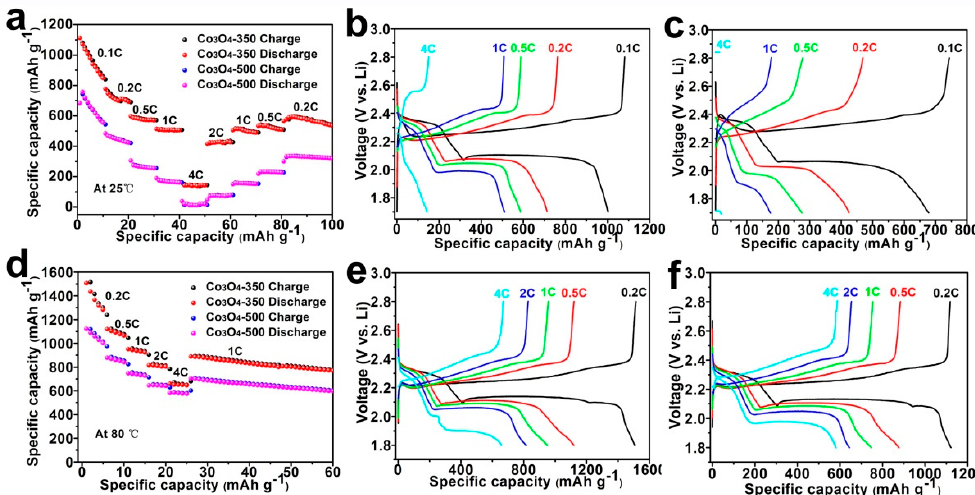
Figure 5. The rate capability of Li–S cell using varied separators at room temperature ( a ) and 80 ◦ C ( d ). The galvanostatic charge / discharge profiles of Li–S cell using Co 3 O 4 -350 / PI / LLZO separator at room temperature ( b ) and 80 ◦ C ( e ). The galvanostatic charge / discharge profiles of Li–S cell using Co 3 O 4 -500 / PI / LLZO separator at room temperature ( c ) and 80 ◦ C ( f ).